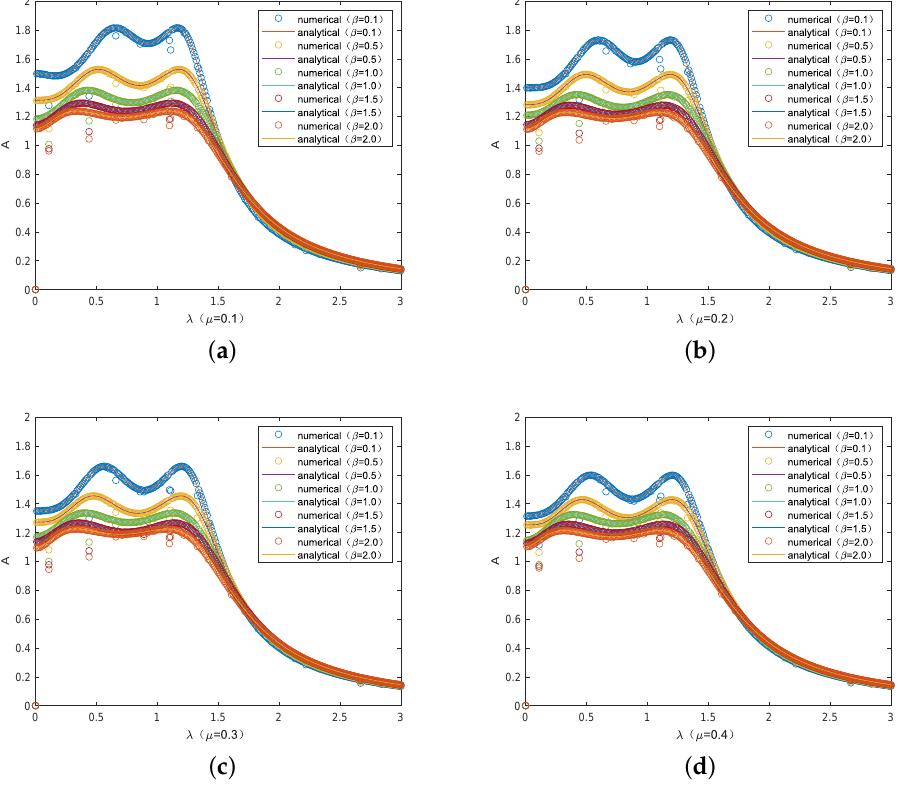
Figure 10. Comparison between numerical solution and analytical solution when optimizing four variables, α 1 , α 2 , ν , and ξ , at the same time: ( a ) µ = 0.1; ( b ) µ = 0.2; ( c ) µ = 0.3; ( d ) µ =